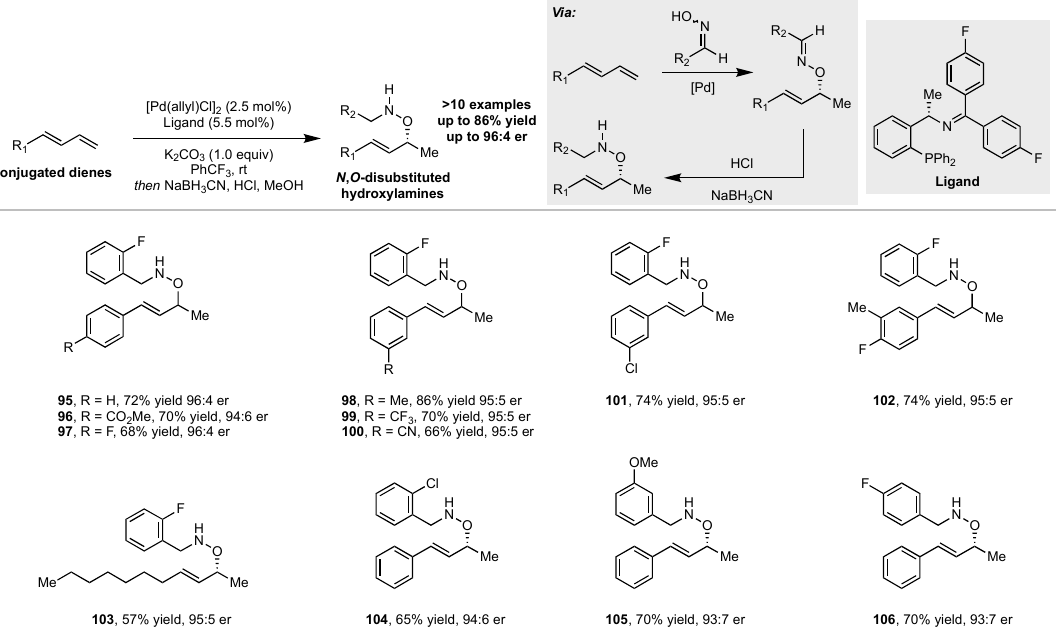
Scheme 9. Lin and He’s catalytic asymmetric synthesis of secondary allylic hydroxylamines from conjugated dienes